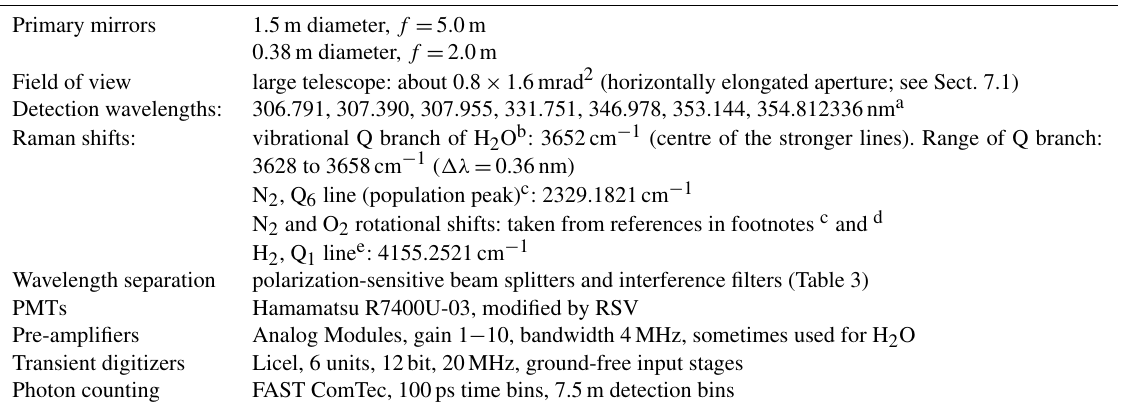
Table 2. Receiver